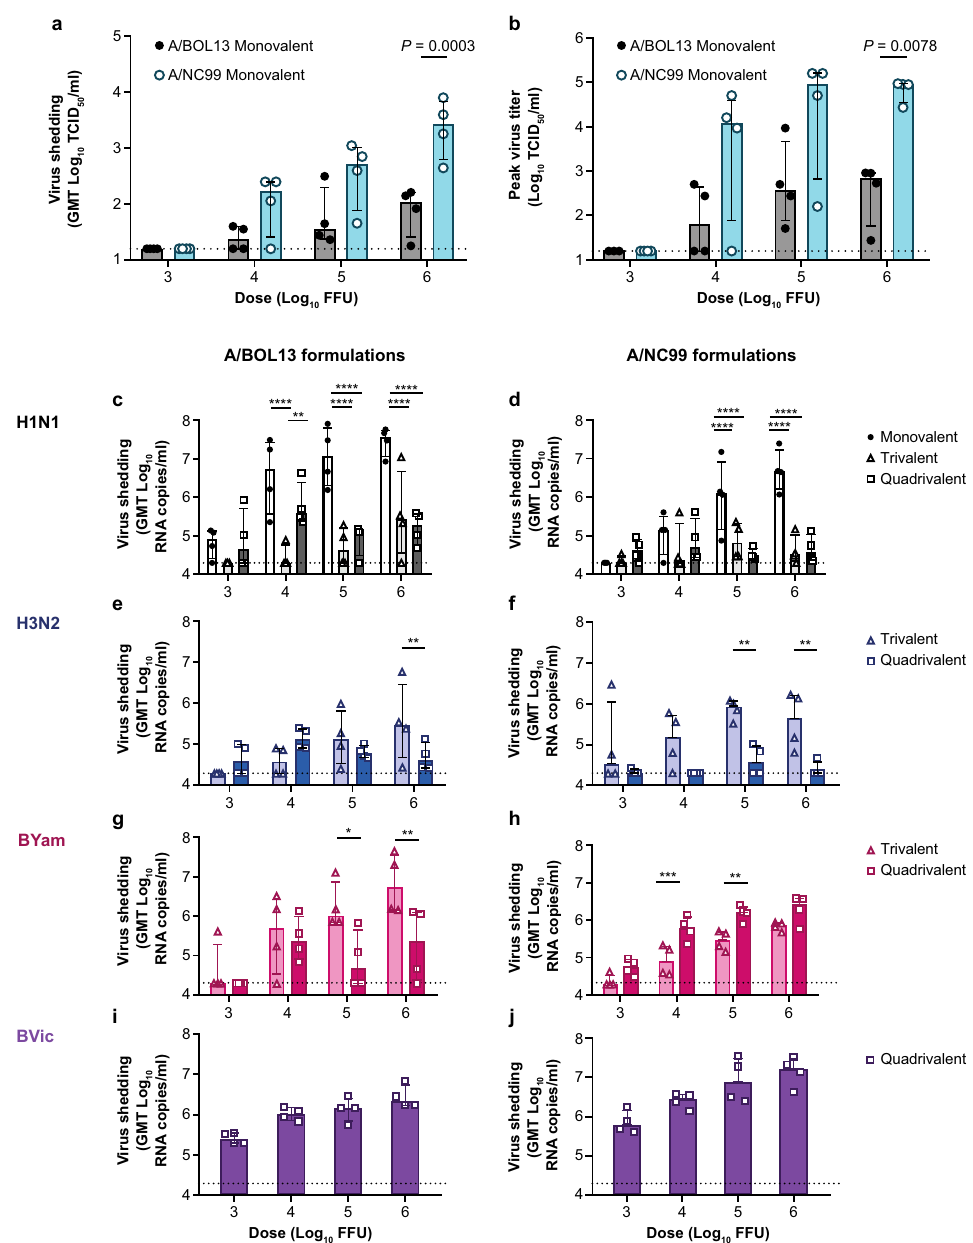
Fig. 2 Monovalent A/BOL13 shedding is reduced relative to A/NC99 and all H1N1 virus shedding is inhibited in multivalent formulations. Comparison of virus shedding for all strains in A/BOL13 and A/NC99 formulations. a Geometric mean Day 1 – 5 shedding of monovalent LAIV H1N1 strains, measured by TCID 50 . b Monovalent LAIV H1N1 peak titer post-vaccination. c – j Shedding of all strains in monovalent, trivalent, and quadrivalent LAIV formulations, measured by multiplex RT-qPCR. Virus shedding in A/BOL13 formulations are shown in c (A/BOL13), e (A/SWITZ13), g (B/PHUK13), and i (B/BRIS08). Virus shedding in A/NC99 formulations are shown in d (A/NC99), f (A/SWITZ13), h (B/PHUK13), and j (B/BRIS08). Geometric mean virus titers for individual animals are indicated by the circle, triangle, and square symbols on the graphs, with 4 animals per dose group. Columns and error bars for all virus titer data show group median and interquartile range. Statistical comparison between groups was performed by two-way analysis of variance with Sidak ’ s post-test correcting for multiple comparisons. * P < 0.05, ** P < 0.01, *** P < 0.001, **** P < 0.0001. Dotted lines indicate lower limit of detection; values below this were plotted as 0.5× the lower limit of detection. A/BOL13 A/Bolivia/559/2013, A/NC99 A/New Caledonia/20/1999, A/SWITZ13 A/Switzerland/9715293/2013, B/BRIS08 B/Brisbane/60/2008, B/PHUK13 B/Phuket/3073/2013, GMT geometric mean titer, LAIV live attenuated in fl uenza vaccine, RT-qPCR quantitative reverse transcription-polymerase chain reaction, TCID 50 tissue culture infectious dose low levels of response detectable in low-dose groups. By contrast, vaccine doses producing the lowest response. In 3.0 and 4.0 log 10 while magnitudes tended to be reduced relative to MLAIV, all A/ FFU A/BOL13 dose groups, no TLAIV- and only two QLAIV- NC99 TLAIV- and QLAIV-vaccinated animals produced detectable vaccinated animals generated detectable HAI titers, versus HAI responses at all doses. Indeed, A/NC99 TLAIV HAI and MN geometric mean HAI responses of ~10 log 2 in MLAIV animals at responses were statistically indistinguishable from MLAIV in 3.0 the same doses. The same trend was apparent by MN, but with